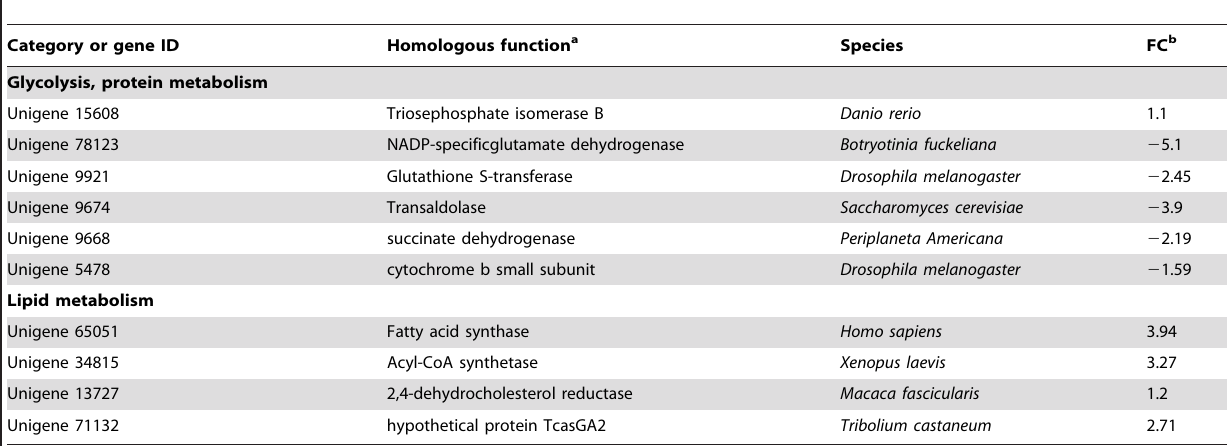
Table 2. Expression profiles of genes involved in the primary metabolism pathway of viruliferous Sogatella furcifera